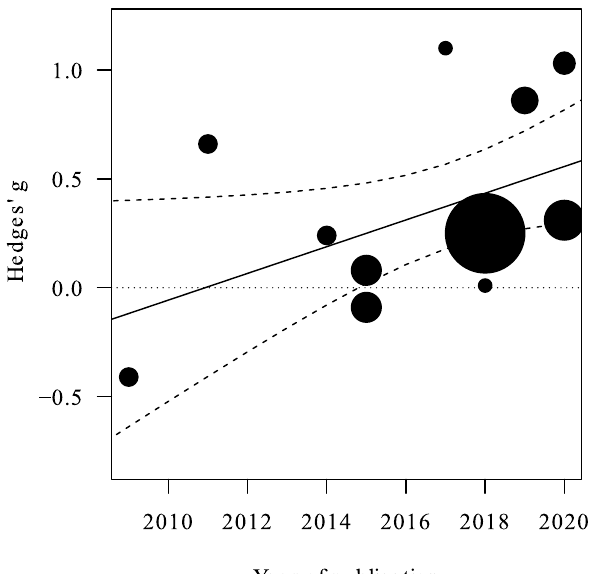
Figure 5. Plot illustrating the relationship between year of publication and cumulative effect sizes. In particular, the most recent the study, the greater the effect size. The area of the points is proportional to study variances. Three studies published in 2020 are not reported due to overlapping positions. Dashed lines indicate 95% CI, the dotted line indicate Hedges’ g = 0 (i.e., no difference between groups).